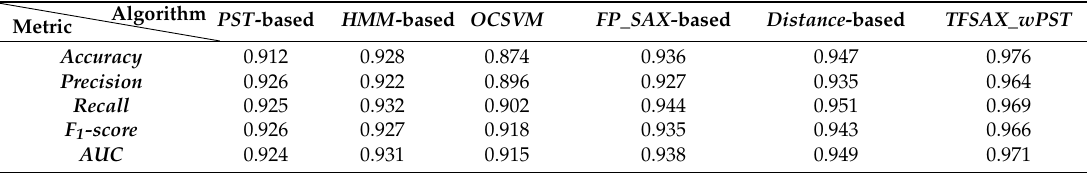
Table 11. Anomaly detection results for the Poyang Lake dataset.